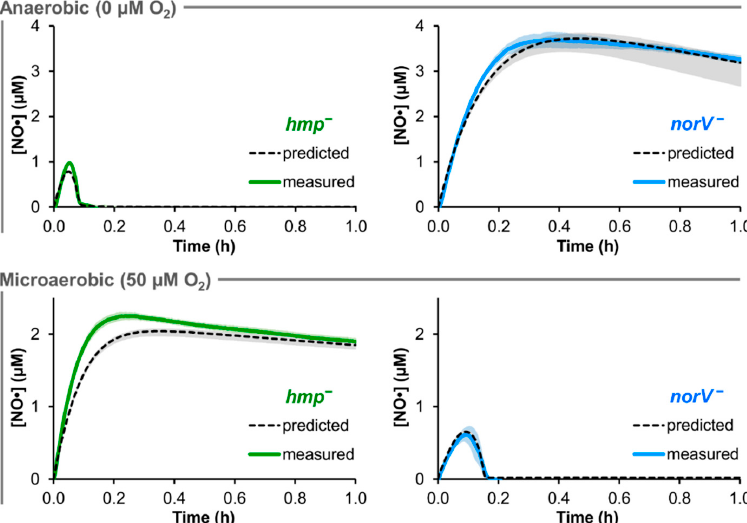
Figure 3. Comparison of predicted and measured [NO·] at 0 and 50 μ M O 2 for hmp − and norV − EHEC. 50 μ M DPTA NONOate treatment was simulated for conditions of 0 and 50 μ M O 2 in cultures of TUV hmp − / norV + and hmp + / norV − at an OD 600 of 0.05, where the black dashed line was obtained using the best-fit parameter set, and gray shading represents prediction uncertainty (range of viable parameter sets with ER < 10). The corresponding experiments for each condition and mutant were performed, and are shown as solid green ( hmp − / norV + ) or solid blue ( hmp + / norV − ) curves (mean of 3 independent experiments, with light shading of the same color representing the SEM).